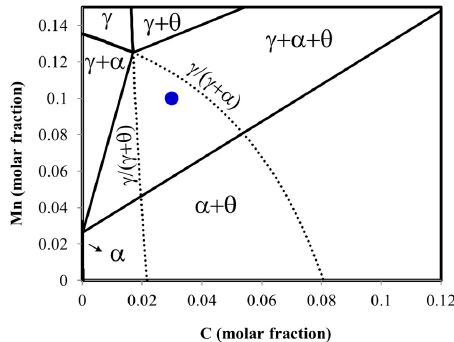
Figure 2. Isothermal section at 600 °C for the studied Mn-steel at 0.0966 Mn fixed. The black dashed lines are the extrapolated γ /( γ + α ) and γ /( γ + θ ) phase boundaries. An example of the microstructure obtained after isothermal heat treatment at 670 °C for 3 and 13 days in Al-steel are presented in Figure 3a,b. After 13 days, the achieved volume fraction of pearlite